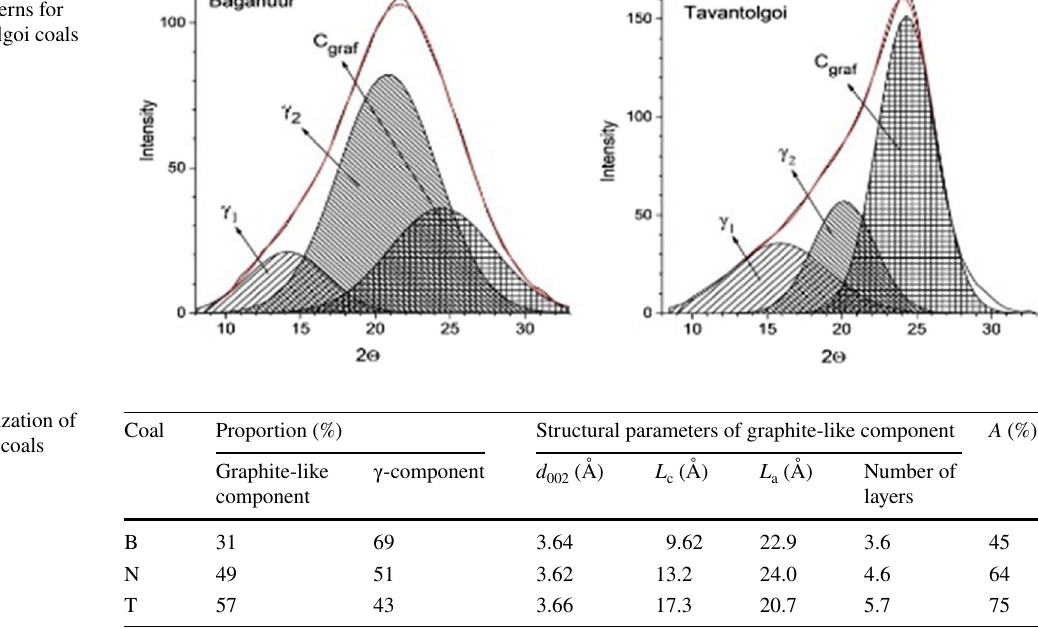
Fig. 4 The deconvoluted frag- ments of the XRD patterns for Baganuur and Tavantolgoi coals